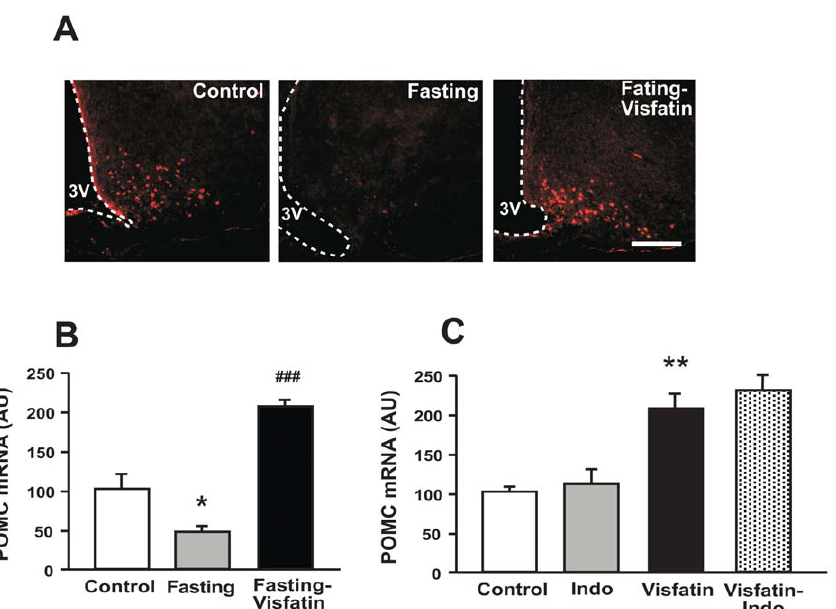
Figure 5. Effect of ICV administration of visfatin on a -MSH synthesis in the ARC. To determine the effect of visfatin on a -MSH synthesis, visfatin was ICV-injected into the lateral ventricles of rats deprived of food for one day. Ninety minutes after the injection, the rats were sacrificed and their brains were fixed via transcardiac perfusion for IHC or were sliced for excising the ARC using a micropunch. Expressions of a -MSH (A) and POMC (B) were determined through IHC and real-time PCR, respectively. To determine the effects of prostaglandins on visfatin-induced changes in POMC expression, indomethacin (Indo) was IP-injected 30 min prior to injection of visfatin, and its effect was determined using real-time PCR (C). 3V=third ventricle. Data (in B and C) are represented as mean 6 SEM (n=6). *P , 0.05 and **P , 0.01 vs. control rats injected with 0.9% saline solution; ### P , 0.001 vs. fasting. Scale bar =50 m m.